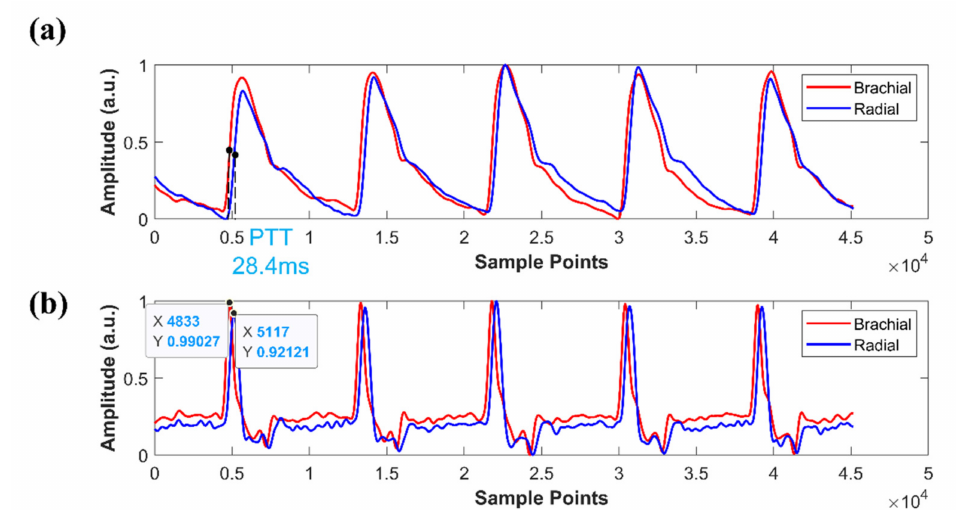
Figure 16. PTT calculation. ( a ) Brachial and radial artery pulse waveforms. ( b ) The first derivative pulse